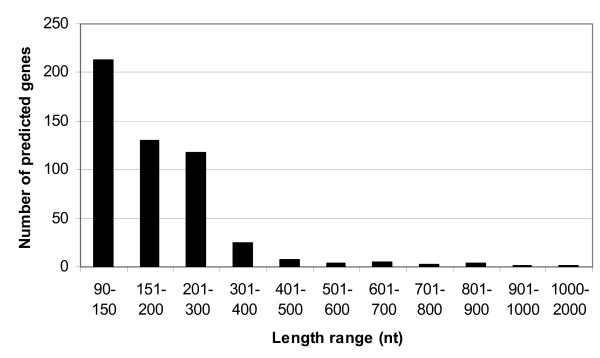
Length distribution of predicted gene candidates.